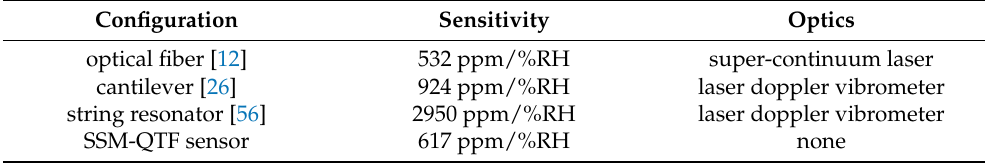
Table 1. Comparison of the SSM-QTF with optical fibers, cantilever, and string resonators. Configuration